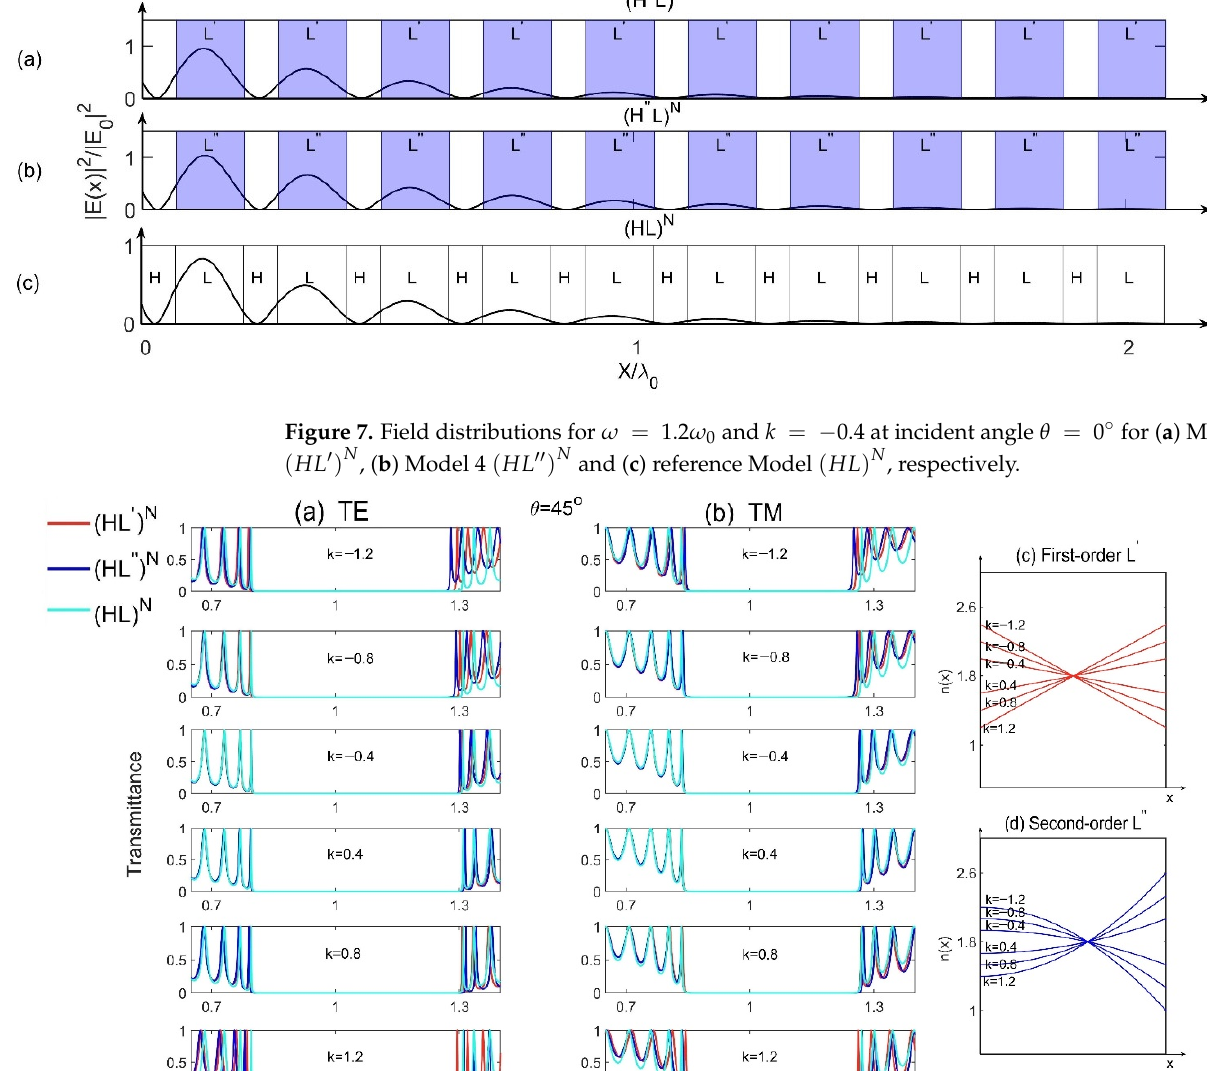
Figure 6. The transmission spectra of Model 3 (𝐻𝐿 (cid:4593) ) (cid:3015) , Model 4 (𝐻𝐿 (cid:4593)(cid:4593) ) (cid:3015) and the reference model (𝐻𝐿) (cid:3015) for different incident angles at slope 𝑘 = −0.4 of the gradient materials for ( a ) TE and ( b ) TM polarizations.